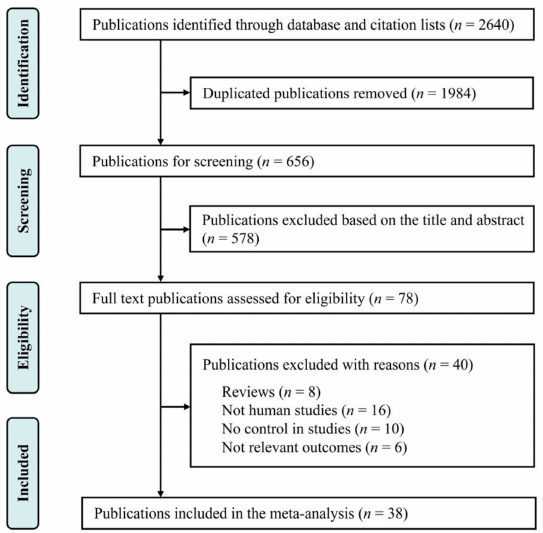
Figure 1. Flowchart depicting the literature search and selection